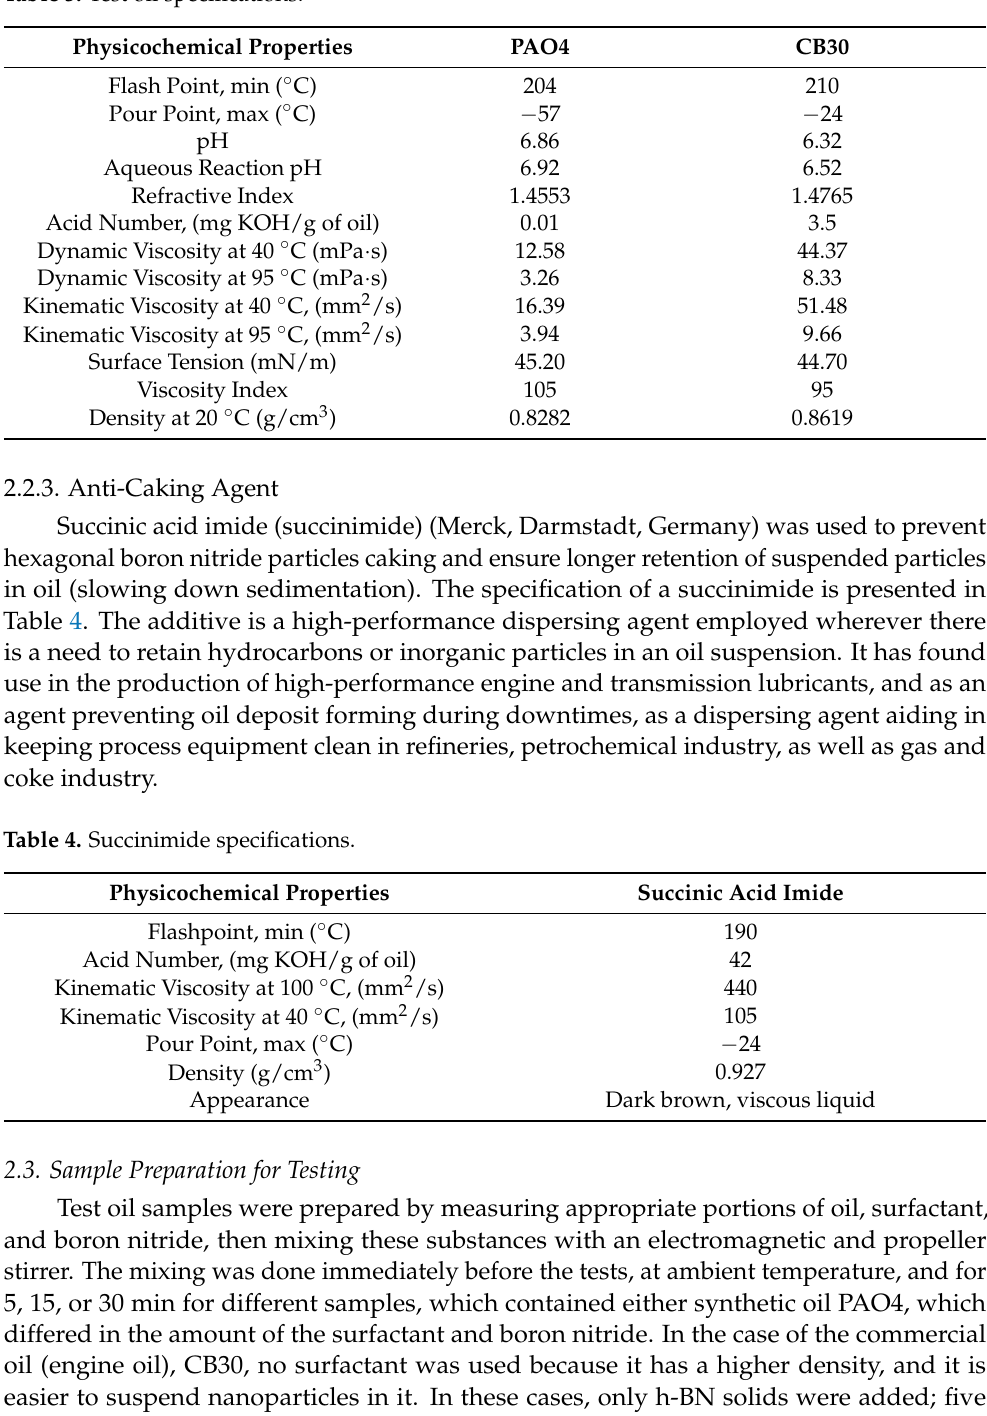
Table 3. Test oil specifications.